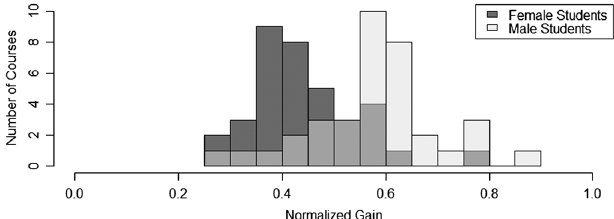
FIG. 2. Histogram of normalized gain for male students (light) and female students (dark) in each class at